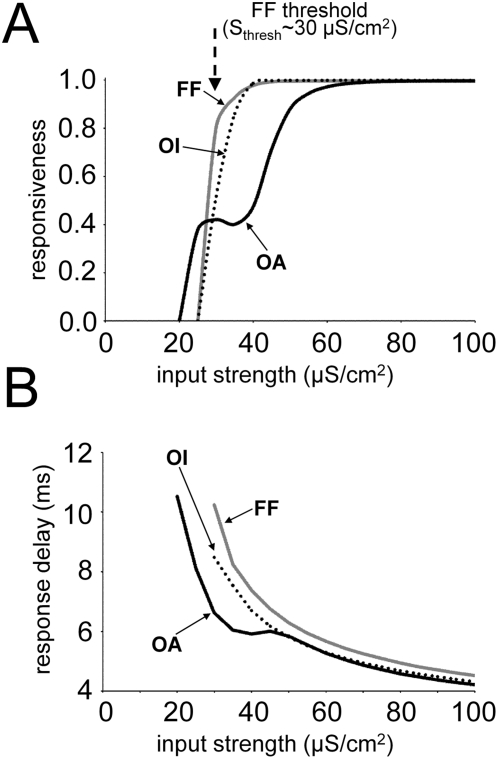
Responsiveness and response delay of each cortical state.(A) The FF network has a step-like shape response function, with a
threshold value of ∼30 µS/cm2. The OA
network shows a more gradual change in its response function with a
plateau near the FF response threshold. Its responsiveness for weak FF
inputs is much stronger than for the other two cases. The OI network
shows little difference in its response function from that of the FF
network. (B) The cortical response to a single FF input spike is fastest
in the OA network for all input strengths. For weak FF inputs, the
average response delay is much shorter in the OA network than in other
network states. As the FF input strength increases, the difference
between OA and OI networks becomes smaller. The FF network always shows
the largest delay time, even for very strong FF inputs.